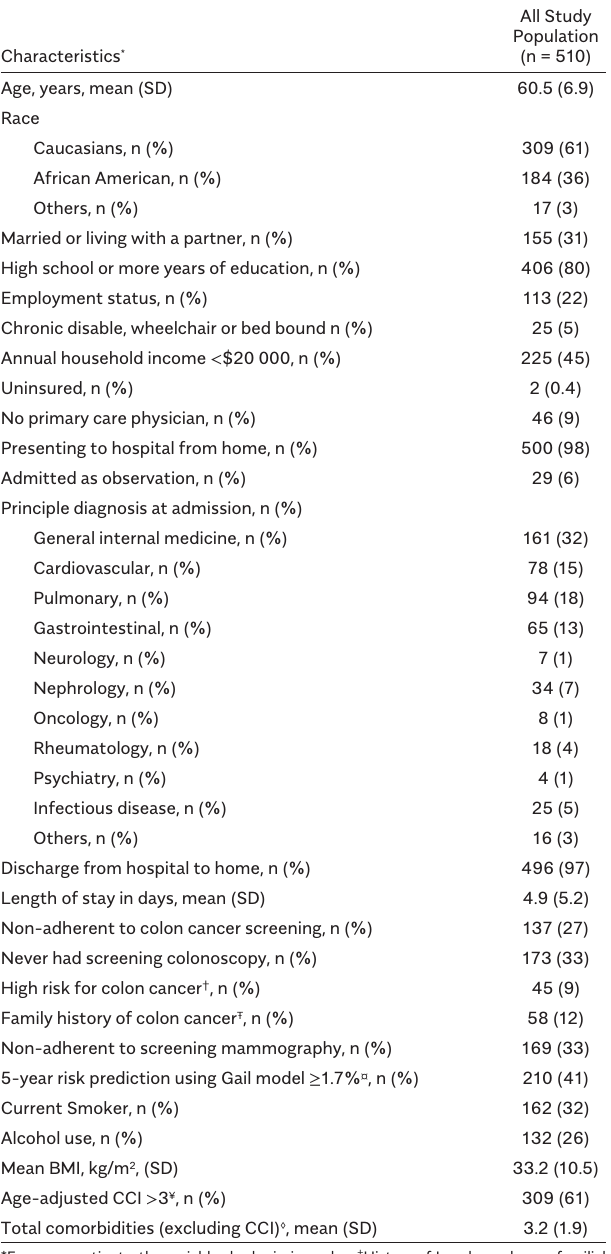
Table 1. Characteristics Study Population